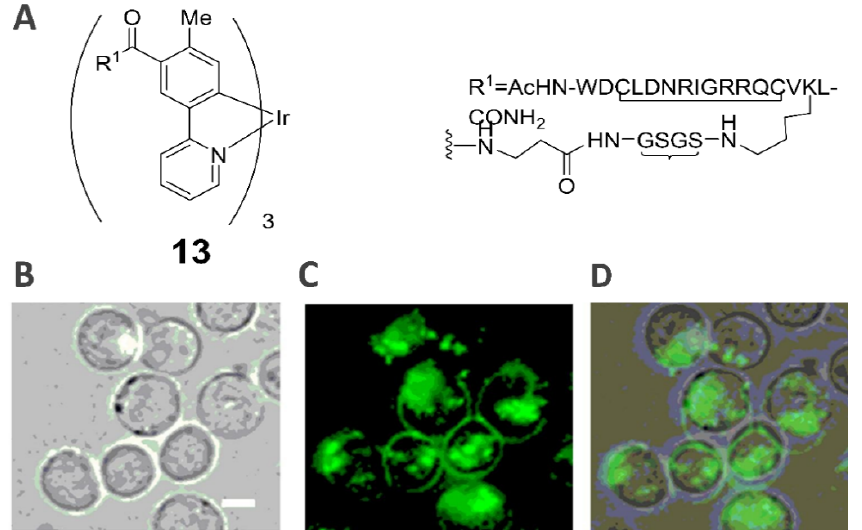
Figure 9. ( A ) Chemical structures of complex 13 . Luminescence images of Jurkat cells incubated with complex 13 (5 μM) at 37 °C for 1 h. ( B ) bright image, ( C ) emission image, ( D ) overlay image of ( B , C ). Scale bar (white) = 10 μm. Reproduced with permission from ref. [71]. Copyright 2018 Elsevier.